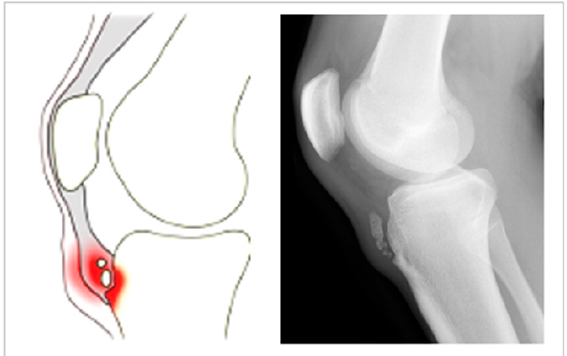
Figure 1. Illustration of the typical features of Osgood-Schlatter disease.